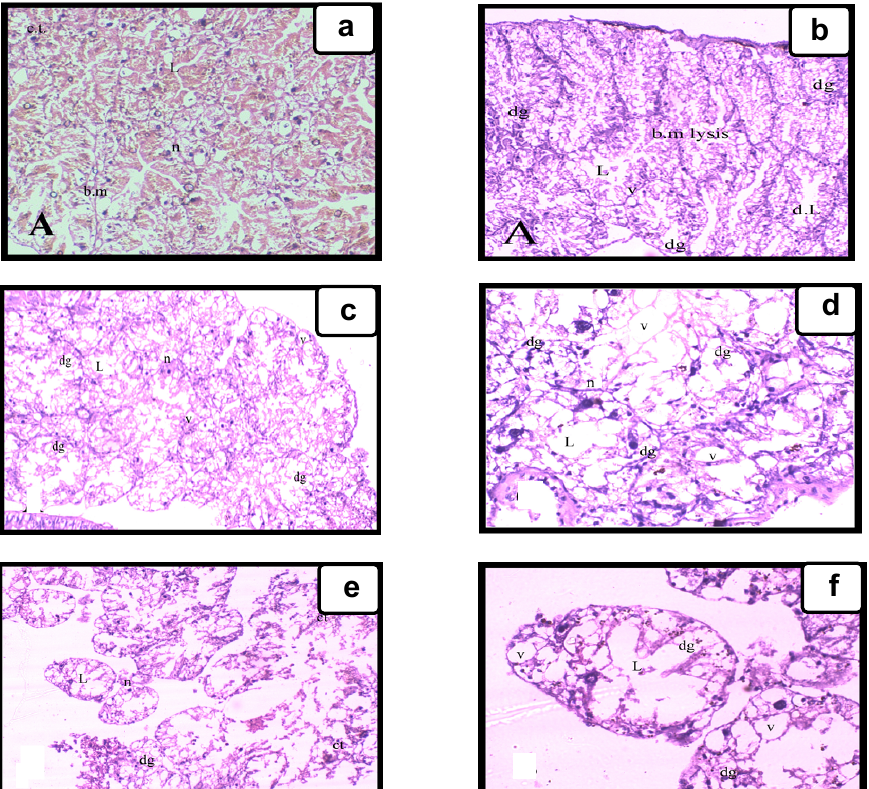
Figure 5. Histopathological examination of the digestive gland sections from land snail, M. cartusiana